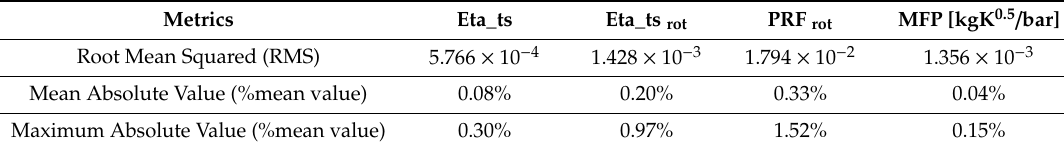
Table 4. Metrics for 4-fold cross validation of the response surfaces.